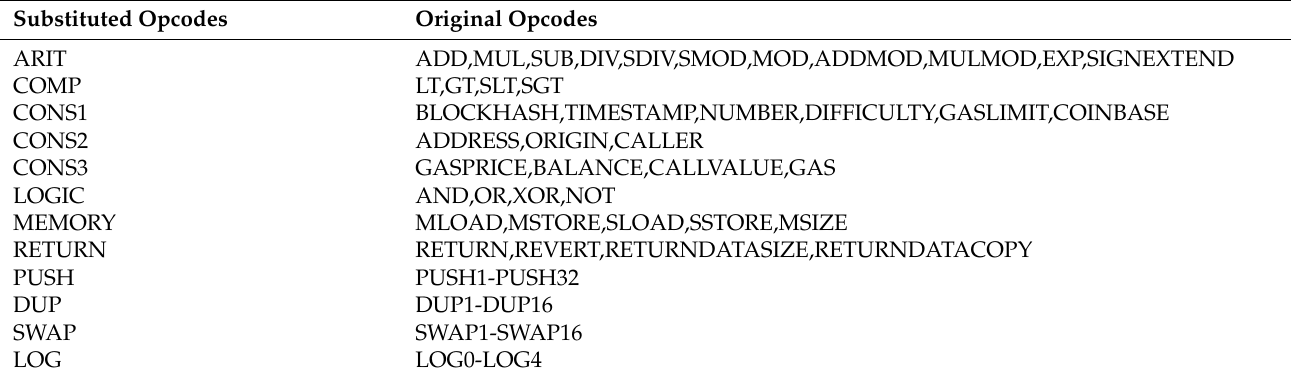
Table 3. The simplified opcode